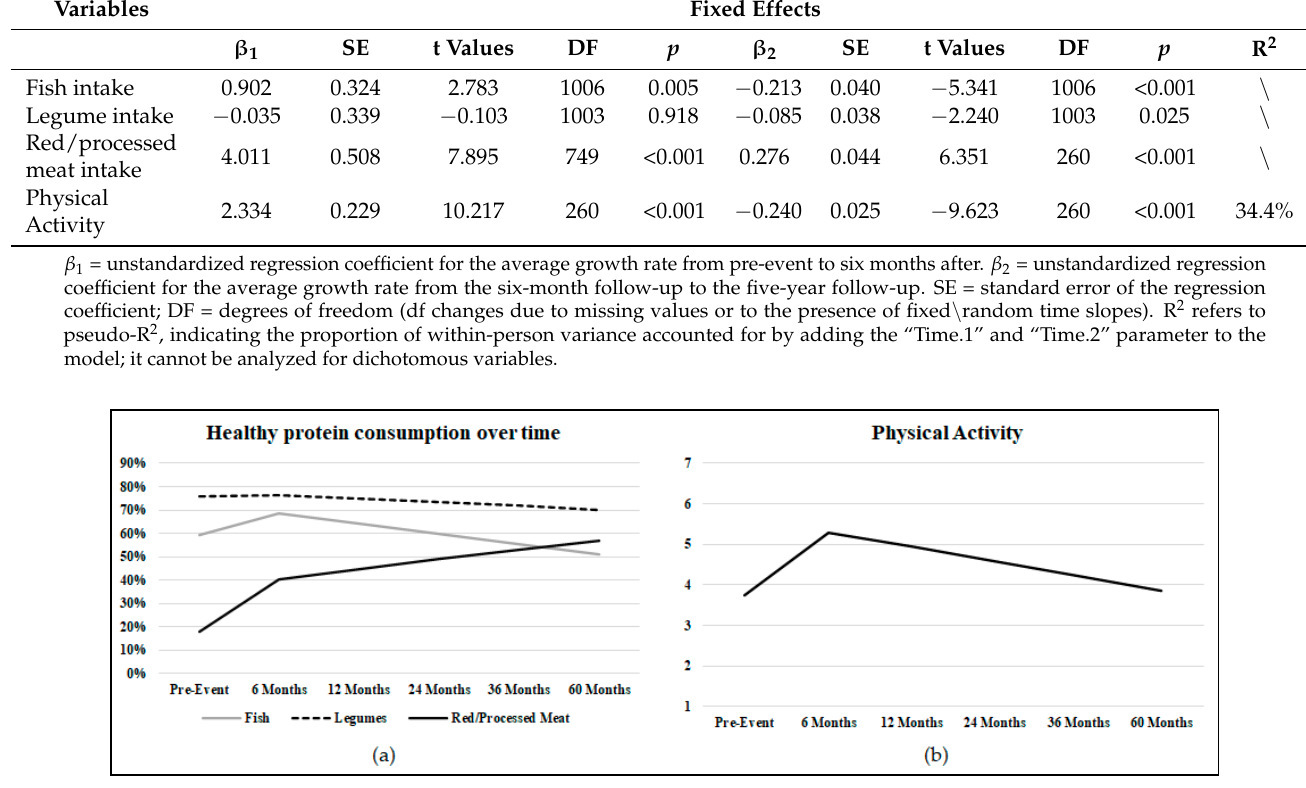
Table 5. Fixed effects for the longitudinal changes in behavioral outcomes (fish intake, legume intake, red/processed meat intake, physical activity).